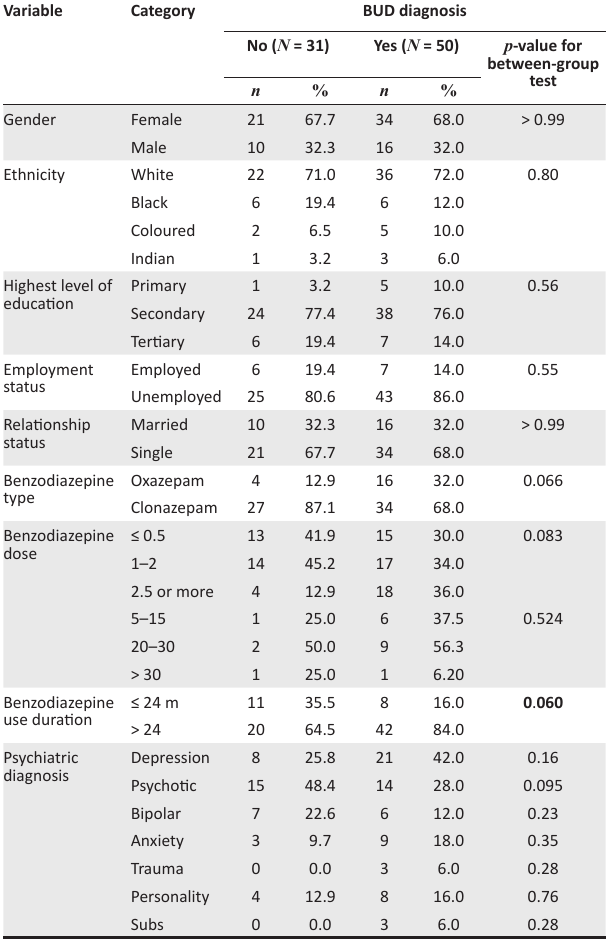
TABLE 1 : Associations between variables and the presence or absence of benzodiazepine use disorder in the study population. Variable